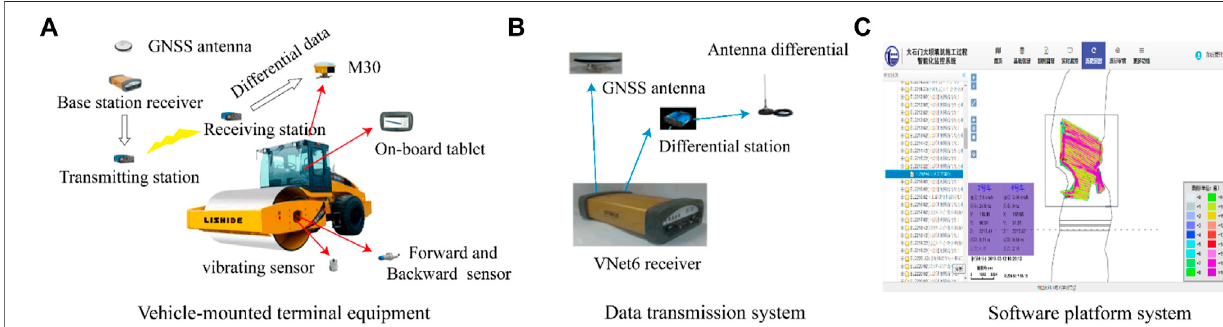
FIGURE 2 | Real-time compaction monitoring system.